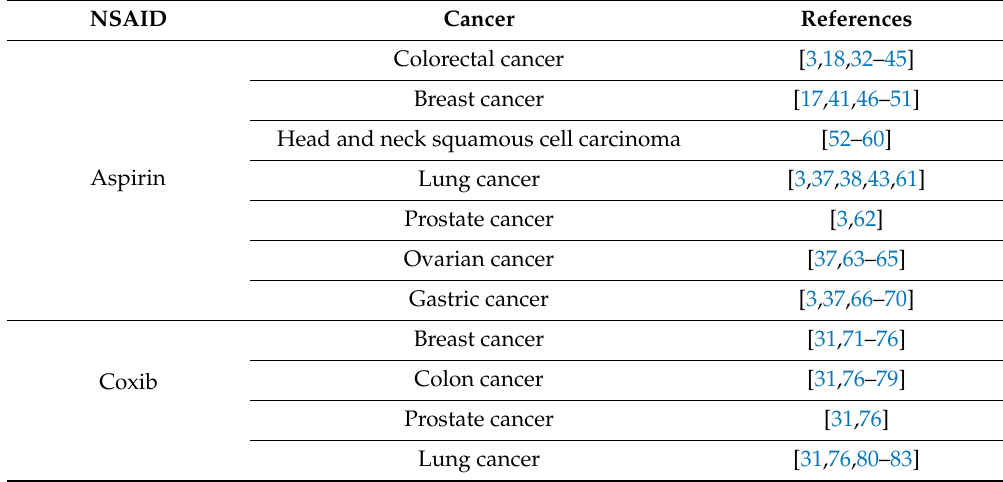
Table 1. Studies related to the role of aspirin and other non-steroidal anti-inflammatory drugs (NSAIDs) in